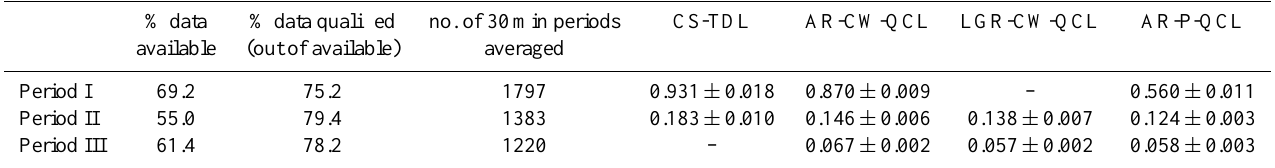
Table 4. Average fluxes (nmolm − 2 s − 1 ) ± random error of the average. Period I DOY 110–181 (20 April–30 June 2011), period II DOY 206–271 (25 July–28 September 2011), period III DOY 272–324 (29 September–20 November 2011). Percent data available represents the fraction of half-hour periods when data from all instruments (three in periods I and III and all four in period II) was available (data from wind direction interval 50–110 ◦ excluded), relative to full time period length. Averaging of fluxes for each instrument was performed only for data if measurements were available for all instruments used in respective period. No gap filling was